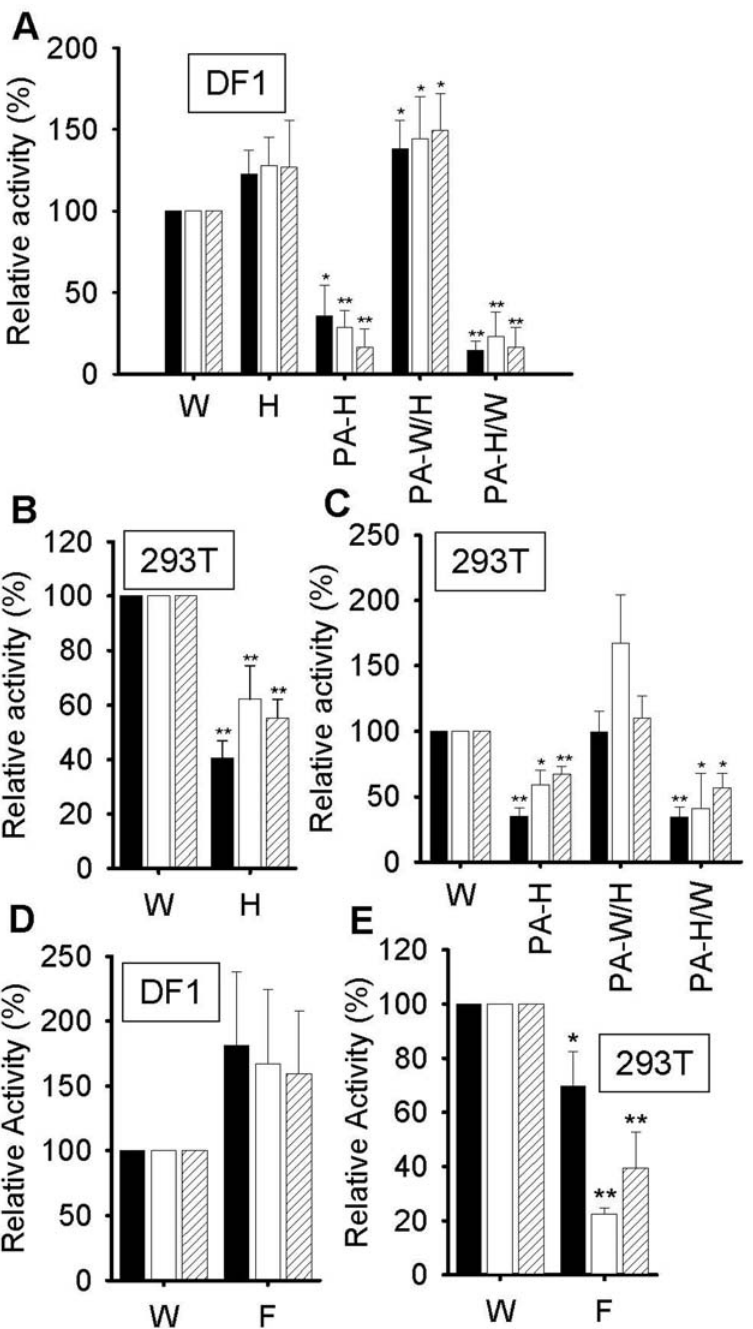
Figure 5. RNP reconstitution assays in chicken DF1 cells and human 293T cells. mRNA, cRNA and vRNA levels were measured by primer extension. (A) RNA levels of RNP derived from WSN (W), HK (H), or from the (PA-H) hybrid of WSN, or from 2 hybrids (PA-W/H or PA-H/W) containing the PA chimeras, were compared in DF1 cells. (B) RNA levels of RNP derived from WSN (W) and HK (H) were compared in human 293T cells. (C) RNA levels of RNP derived from PA-H, PA-W/H and PA-H/W were compared in 293T cells. (D) RNA levels of RNP derived from WSN (W) and Fujian (F) in DF1 cells. (E) RNA levels of RNP derived from WSN (W) and Fujian (F) in 293T cells. In all experiments, activities are expressed as a % relative to the wild-type WSN (W) from 3 independent experiments. Black, white and oblique lined columns show steady-state levels of mRNA, cRNA and vRNA, respectively. * and ** show statistically significant differences from wild-type WSN (W) at p , 0.05 and p , 0.01 in a Student’s t-test. WSN NP was used for WSN and HK strains, and FJ NP was used for the FJ strain.